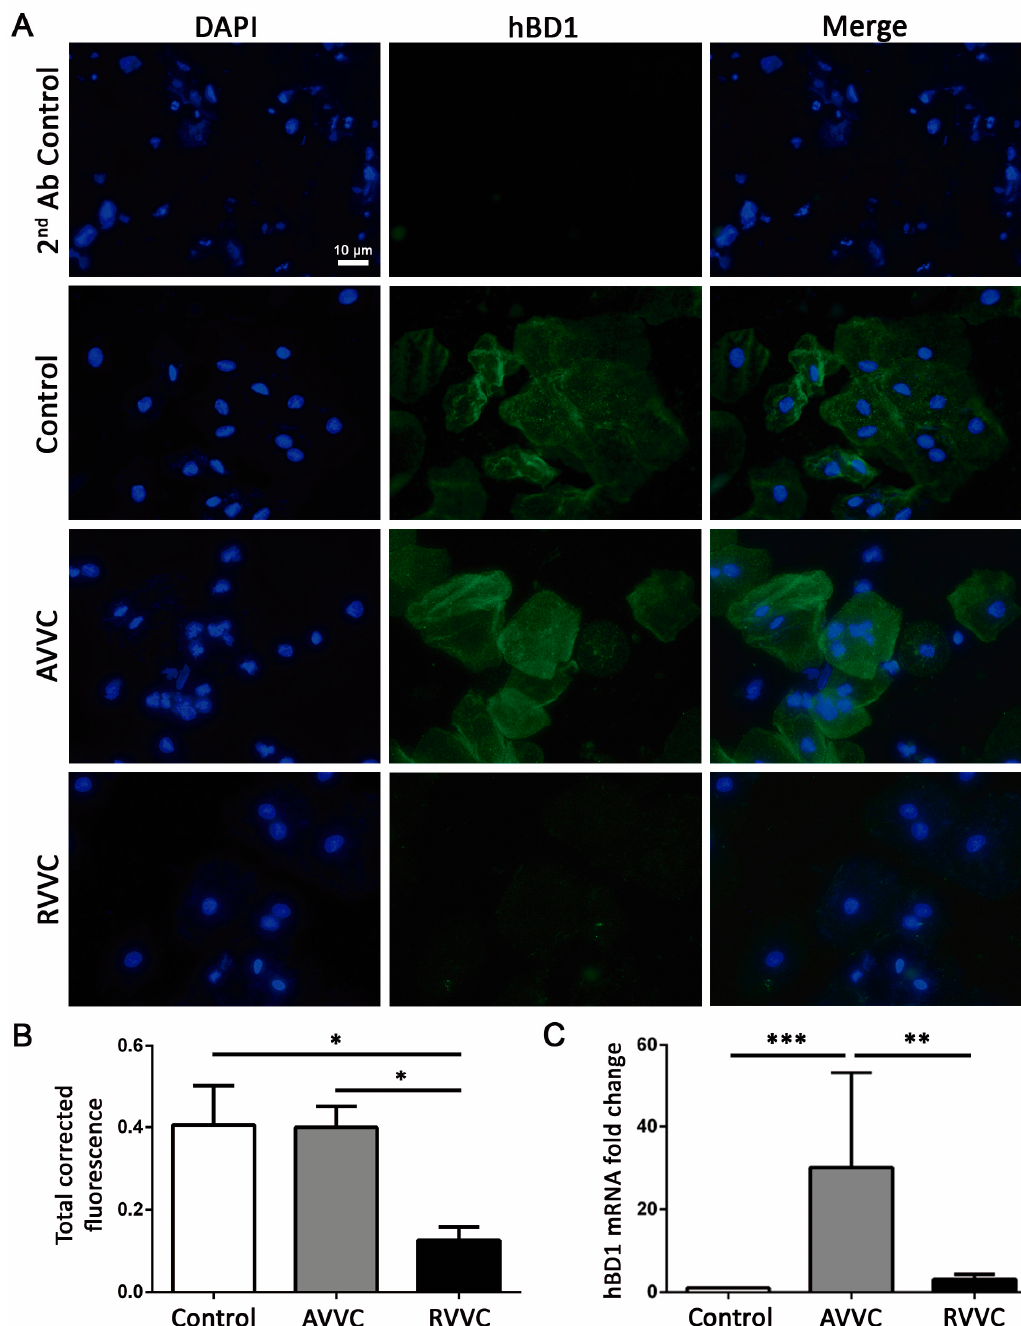
Figure 4. Human Beta Defensin-1 (hBD1) expression in cells of cervicovaginal lavage. ( A ) Immunoflu- orescence of cervicovaginal lavage cytospin samples from Control individuals and patients with AVVC or RVVC. Upper panel (2nd Ab control), cytospin of cervicovaginal lavage from patients with RVVC. Cell nuclei were stained with DAPI (blue), and hBD1 expression is shown in green. Images are shown at × 630 magnification. ( B ) Fluorescence semiquantification was performed using the ImageJ software. The assay could not be performed in all the patients of each cohort due to sample limitations. Mean ± SEM. Control n = 4, AVVC n = 6, RVVC n = 5. * p < 0.05. ( C ) hBD1 mRNA expression by real-time PCR in cervicovaginal lavage cells from Control individuals and patients with AVVC or RVVC. The assay could not be performed in all the patients of each cohort due to sample limitations. Mean ± SEM. Control n = 14, AVVC n = 5, RVVC n = 15. ** p < 0.01, *** p < 0.001. ANOVA